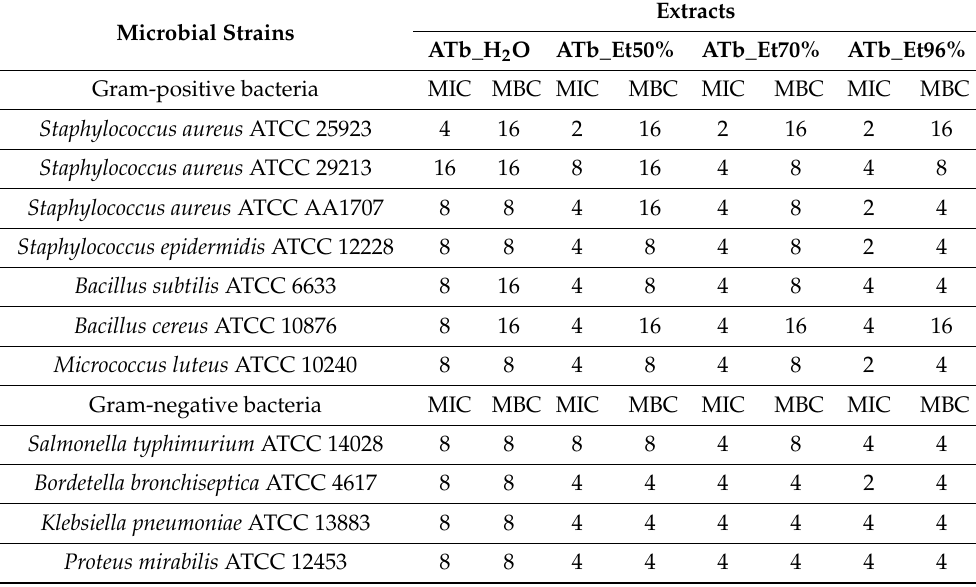
Table 5. MIC (mg/mL) and MBC (mg/mL) and MFC (mg/mL) values of different dried extracts obtained from Allium turkestanicum against reference